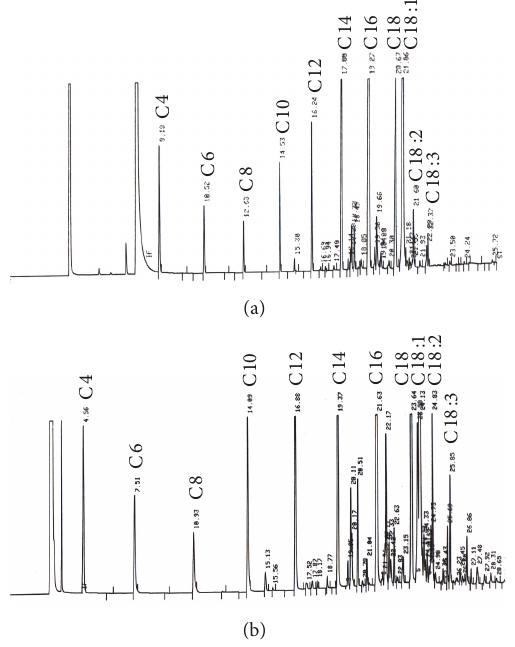
Figure 7: Gas chromatogram of FA pentyl esters (a) and methyl esters (b) in authentic butter.